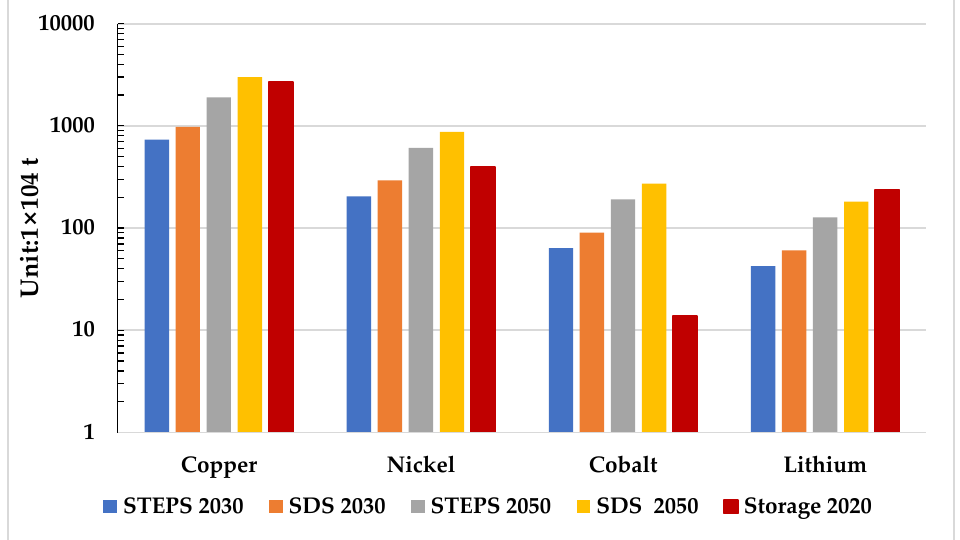
Figure 5. Total mineral resource demand and currency reserves in the clean energy sector under different scenarios (Data Source: [27]).